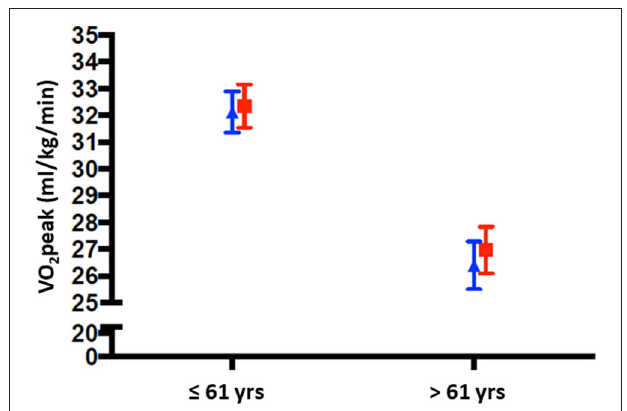
FIGURE 3 | VO 2 peak post-intervention below and over the age cutoff (61 years), presented within the two intensity groups LMI (blue triangle) and HI (red squares). Means are adjusted for VO 2 peak at baseline and study site is included as covariate.